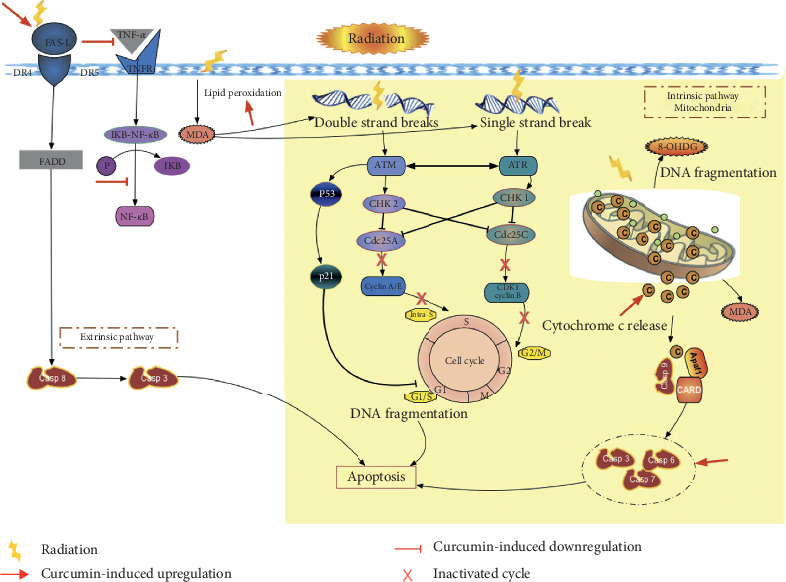
Curcumin-induced apoptotic pathway in human.